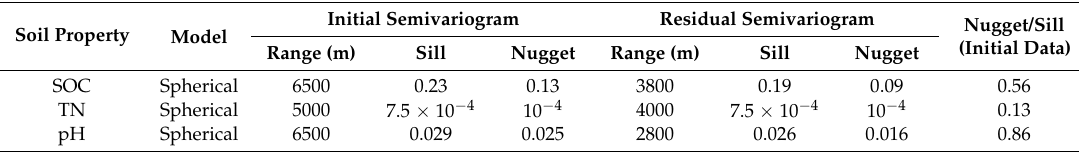
Table 3. Semivariogram